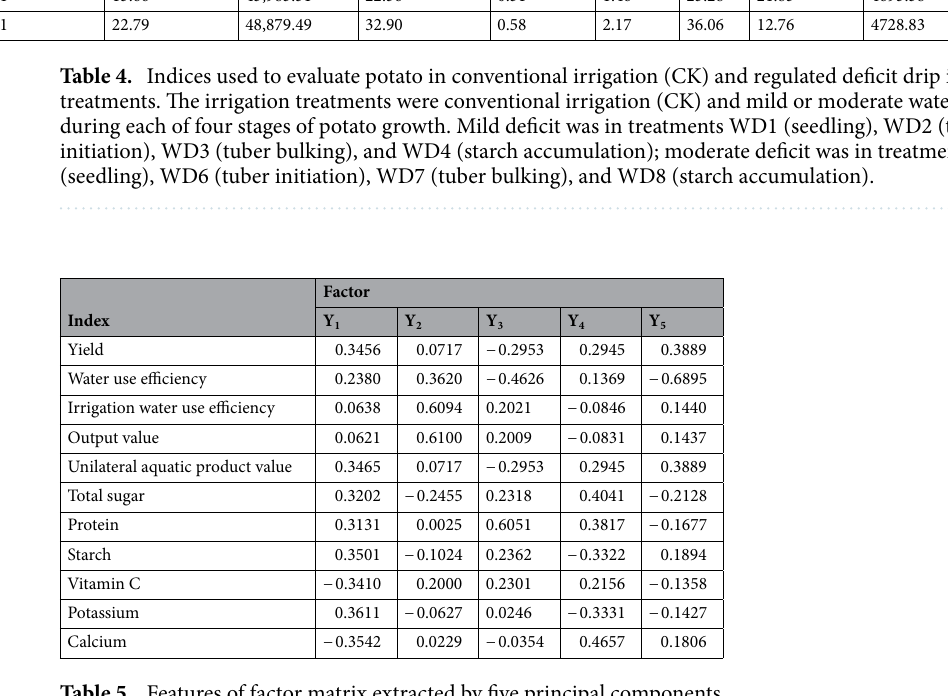
Table 5. Features of factor matrix extracted by five principal components.